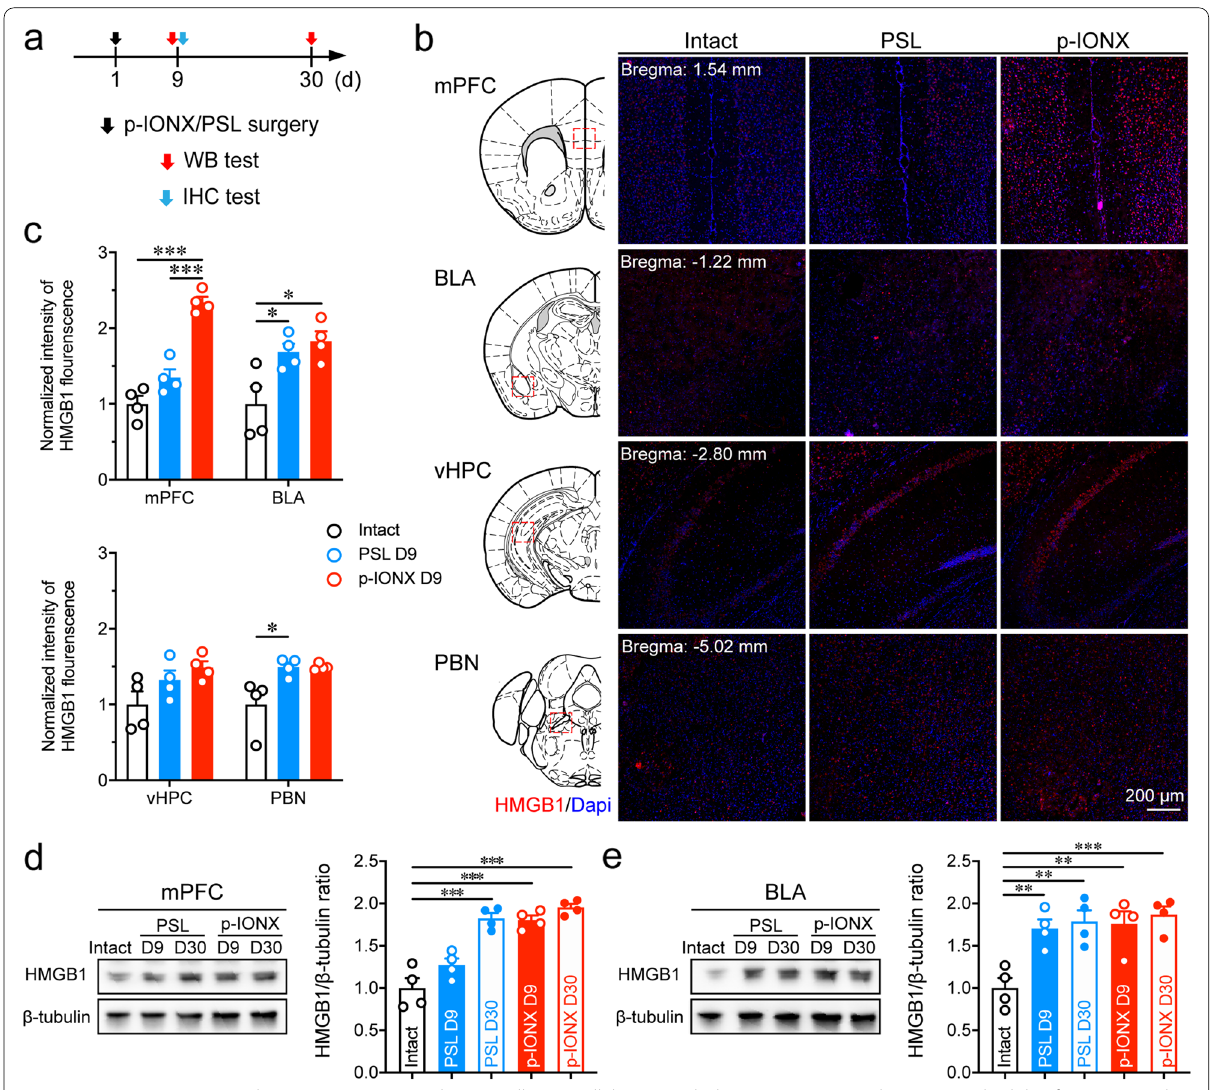
Fig. 2 HMGB1 expression in the mPFC was increased temporally in parallel to comorbid anxiety in neuropathic pain. a Schedule of experimental procedures. b Representative photomicrographs of HMGB1 immunostaining in the mPFC, BLA, vHPC and PBN. Scale bar, 200 μm. c Quantification of HMGB1 fluorescence intensity in the mPFC, BLA, vHPC and PBN on D9 PO. d, e Representative images of protein bands in western blotting (left) and quantification of HMGB1 expression (right) in the mPFC ( d ) and BLA ( e ) on D9 and D30 PO. *, ** and *** indicate P < 0.05, 0.01 and 0.001, respectively, compared with the indicated groups, ordinary one‑way ANOVA with Tukey post hoc or Kruskal–Wallis test with Dunn’s post hoc in ( c ) and ordinary one‑way ANOVA with Dunnett post hoc in ( d ) and ( e ). n =